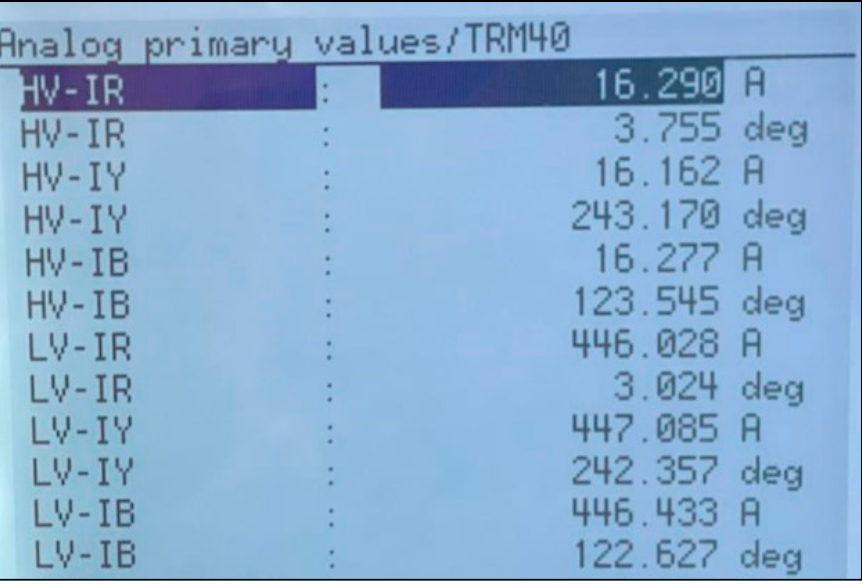
Figure 8. Measured values for HV and LV currents by the relay RET670 display unit [16].